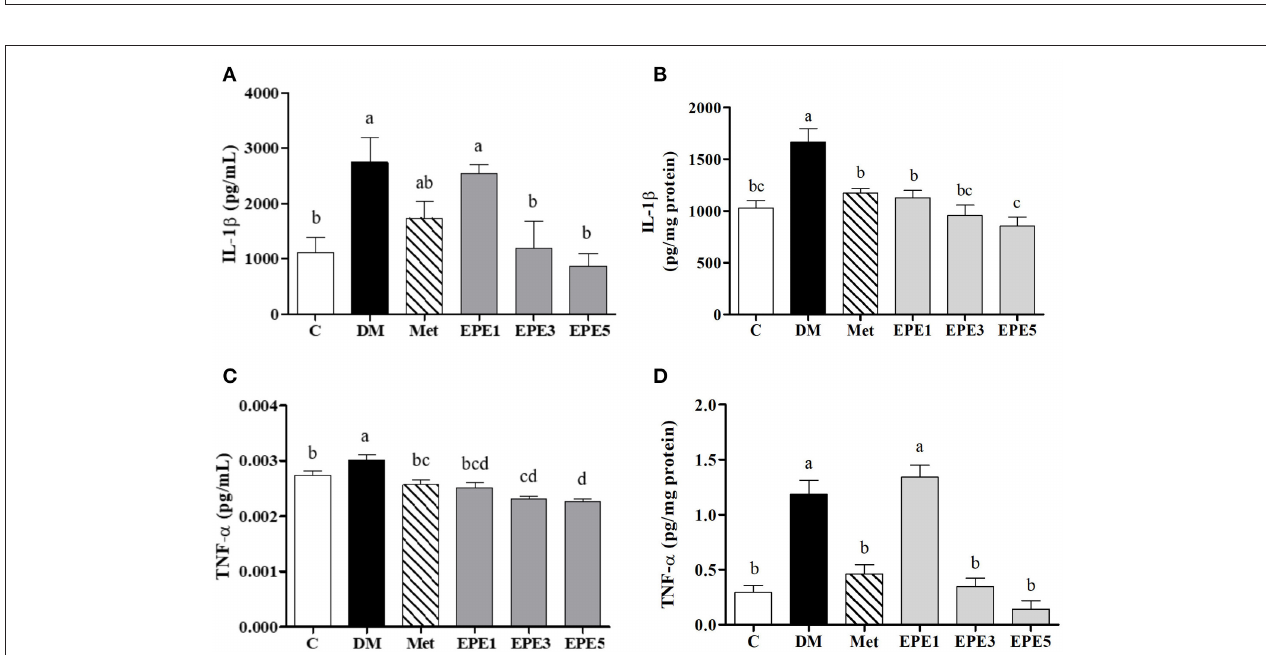
FIGURE 5 | Protein expression of (A) Toll-like receptor 4 (TLR4) and (B) phosphor-NF- κ B p65 in the testes of diabetic rats after 4 weeks of treatments. Data are shown as the mean ± SEM ( n = 6). The values with different superscript letters (a–c) represent significant differences ( p < 0.05) as analyzed by Duncan’s multiple range test. C, control; DM, diabetes mellitus; Met, metformin; EPE, Echinacea purpurea ethanol extract.